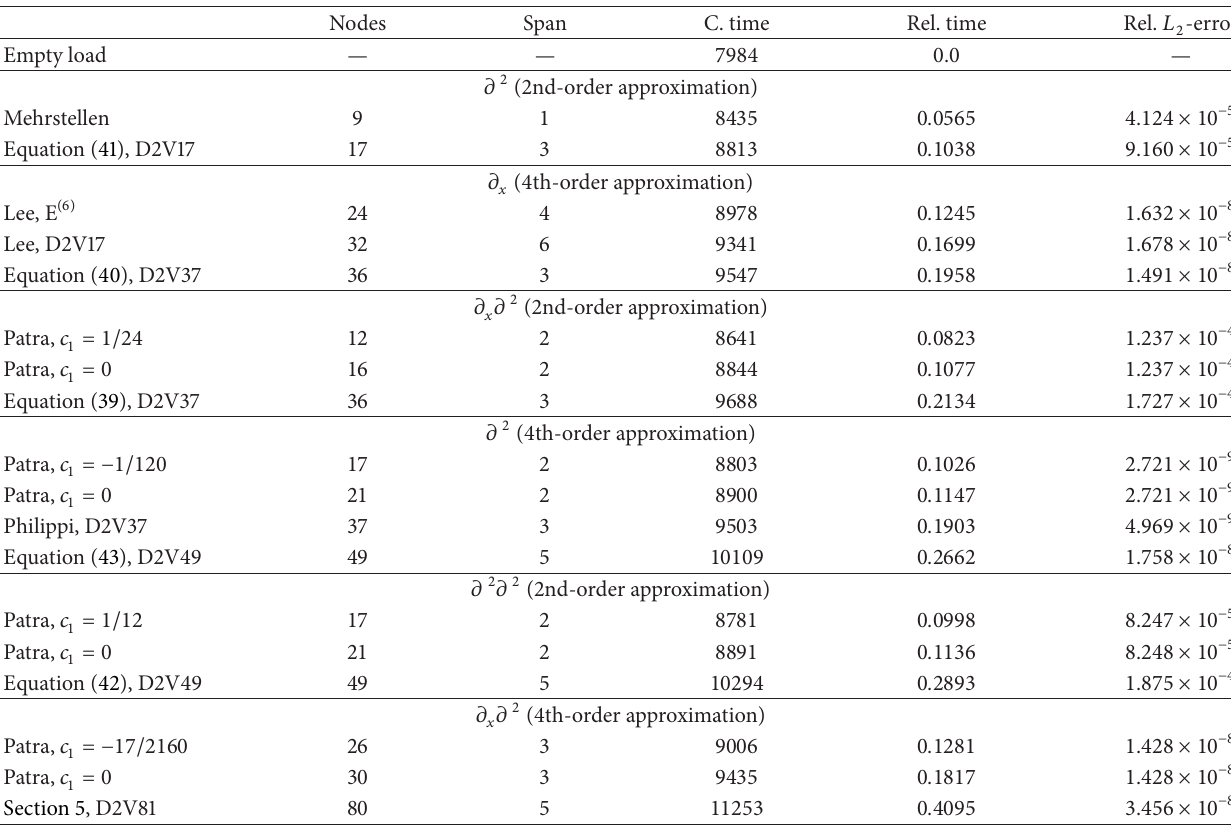
Table 3: Comparison of various approximations for low- and moderate-rank derivatives with second- and fourth-order accuracy. The computational times are given in milliseconds and the Empty load refers to the Mehrstellen case where only the actual approximation is skipped: the relative computational times are defined with respect to the empty load. References for the below compared approximations are as follows: Lee and Lin [11], Lee and Fischer [12], Patra and Karttunen [2], and Philippi et al. [13].